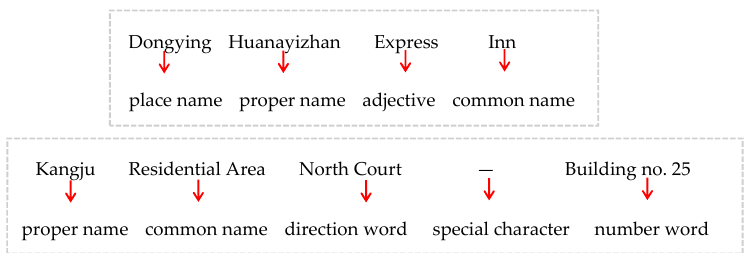
Figure 5. Schematic diagram illustratin the semantic role composition.